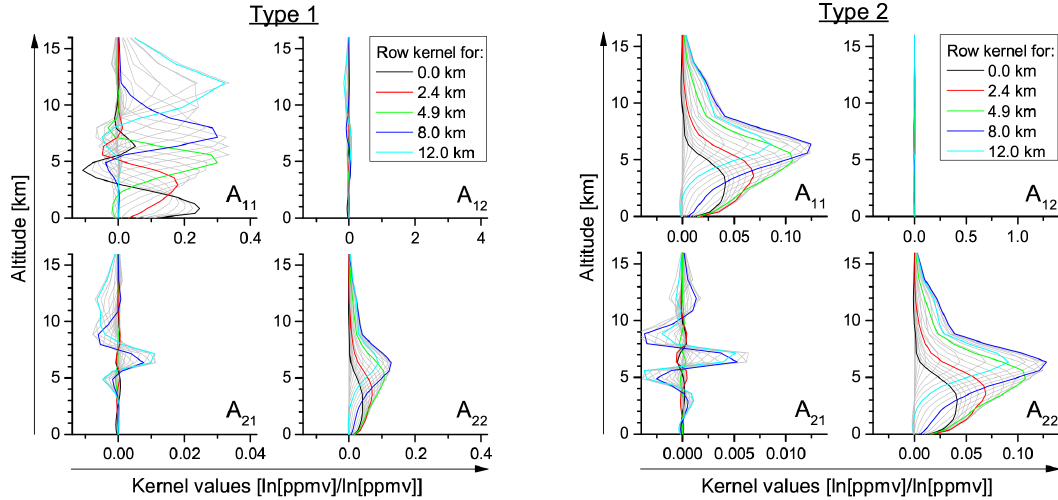
Figure 4. Simulated averaging kernels for the surface and atmospheric conditions corresponding to the averaging kernels of Fig. 1. Panels and colour are as in Fig. 1.